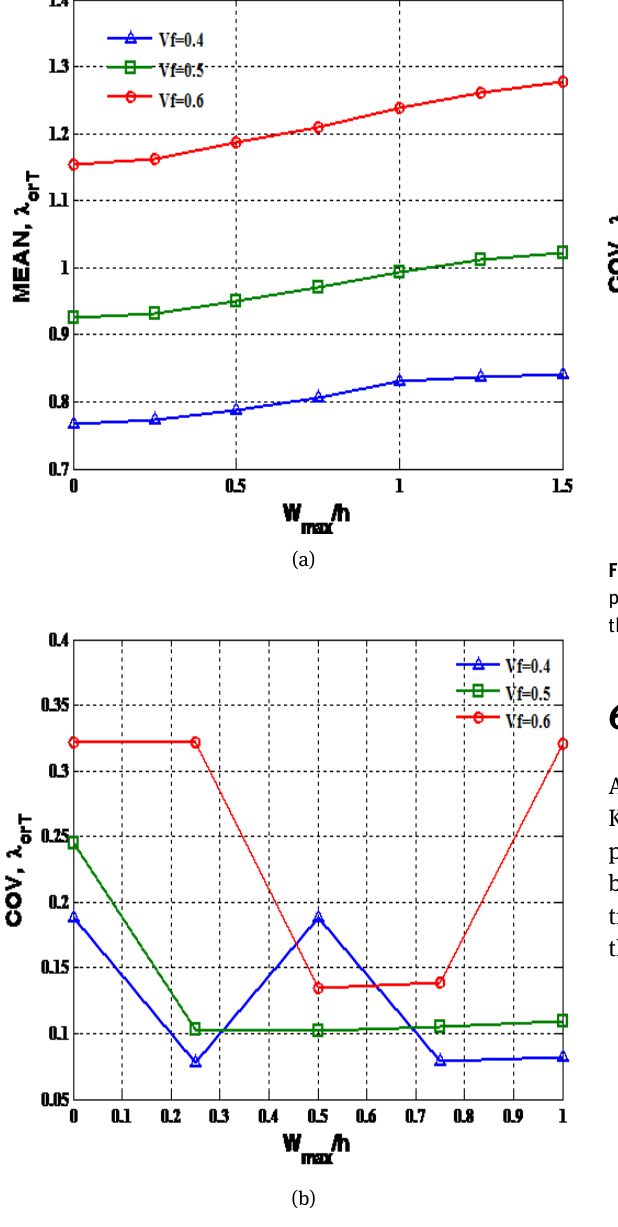
Figure 11: Effect of volume fraction of fiber and amplitude ratios with random change in system parameres on the mean and COV of thermal post buckling temperature.